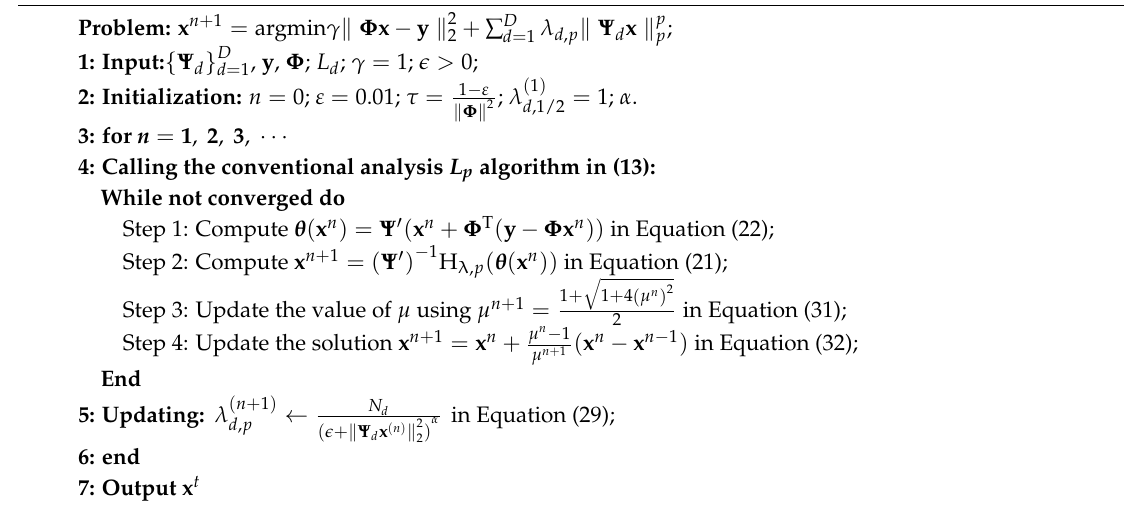
Algorithm 1 : The proposed SAITA- L p algorithm.